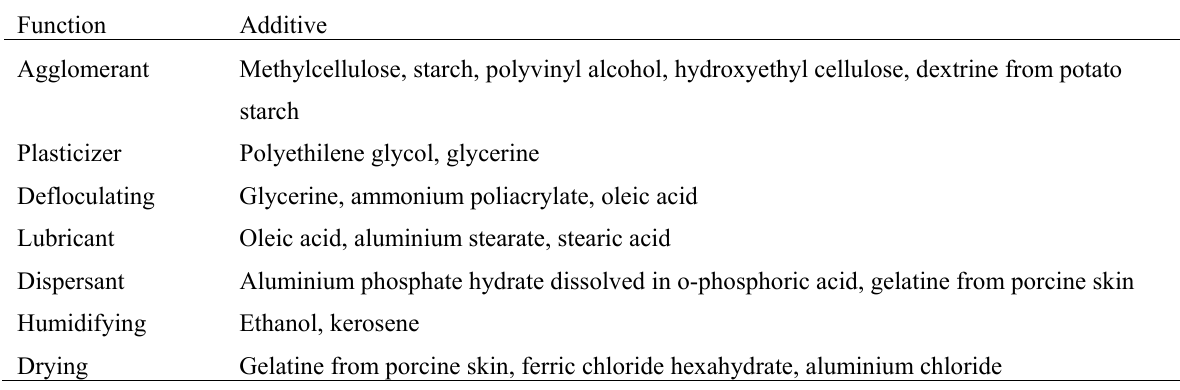
Table 2. Additives that can be used to make extrudable a carbonaceous paste. From reference [31], with permission from Elsevier.